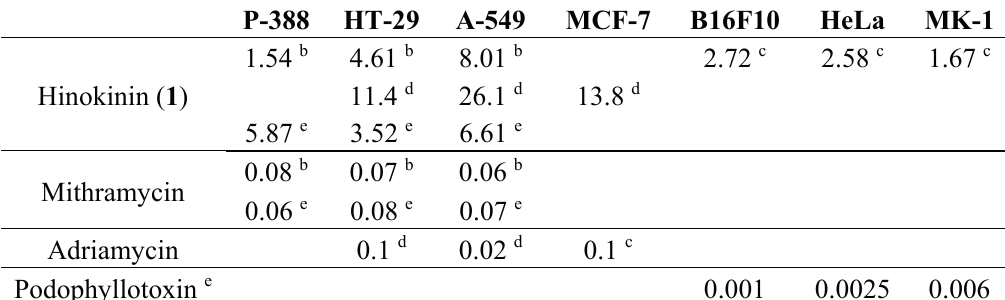
Table 1. Cytotoxicity of hinokinin ( 1 ) against selected tumor cell lines a